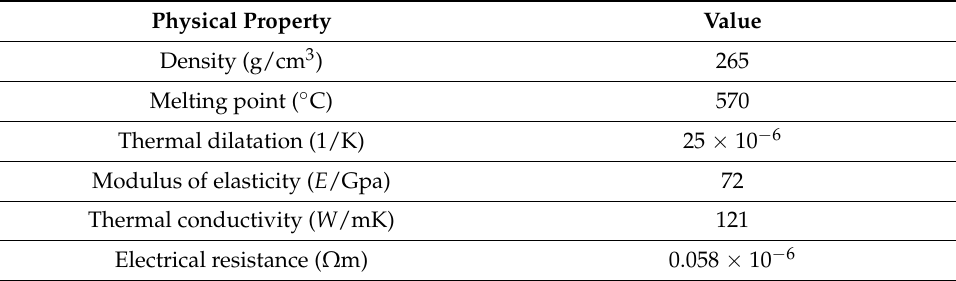
Table 3. Physical properties of AlMg4.5Mn0.7